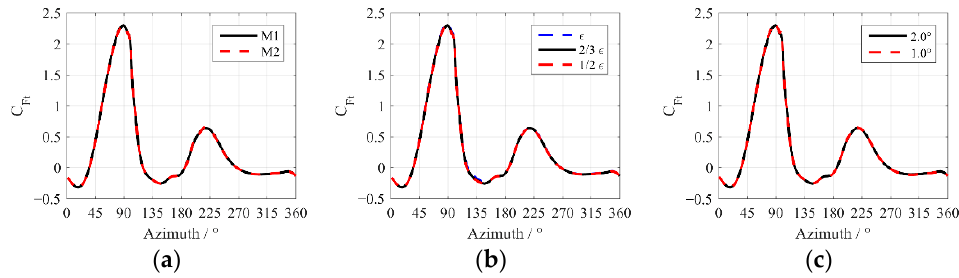
Figure 4. Instantaneous tangential force coefficients of a blade with different ( a ) meshes, ( b ) blade element lengths and ( c ) azimuthal angle step sizes.